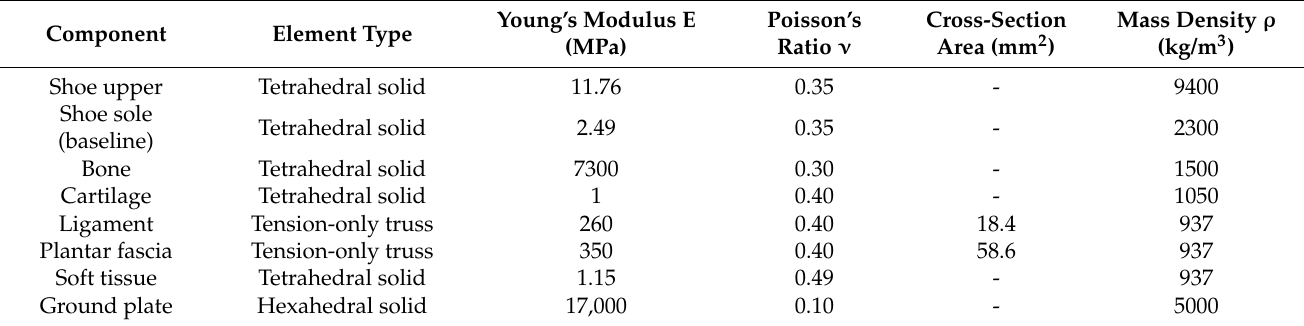
Table 1. Material properties assigned to each component in the finite element